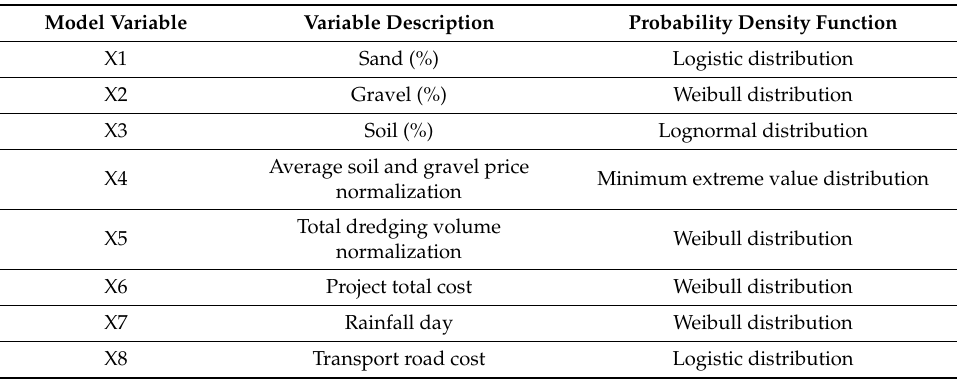
Table 7. Probability density functions of the model